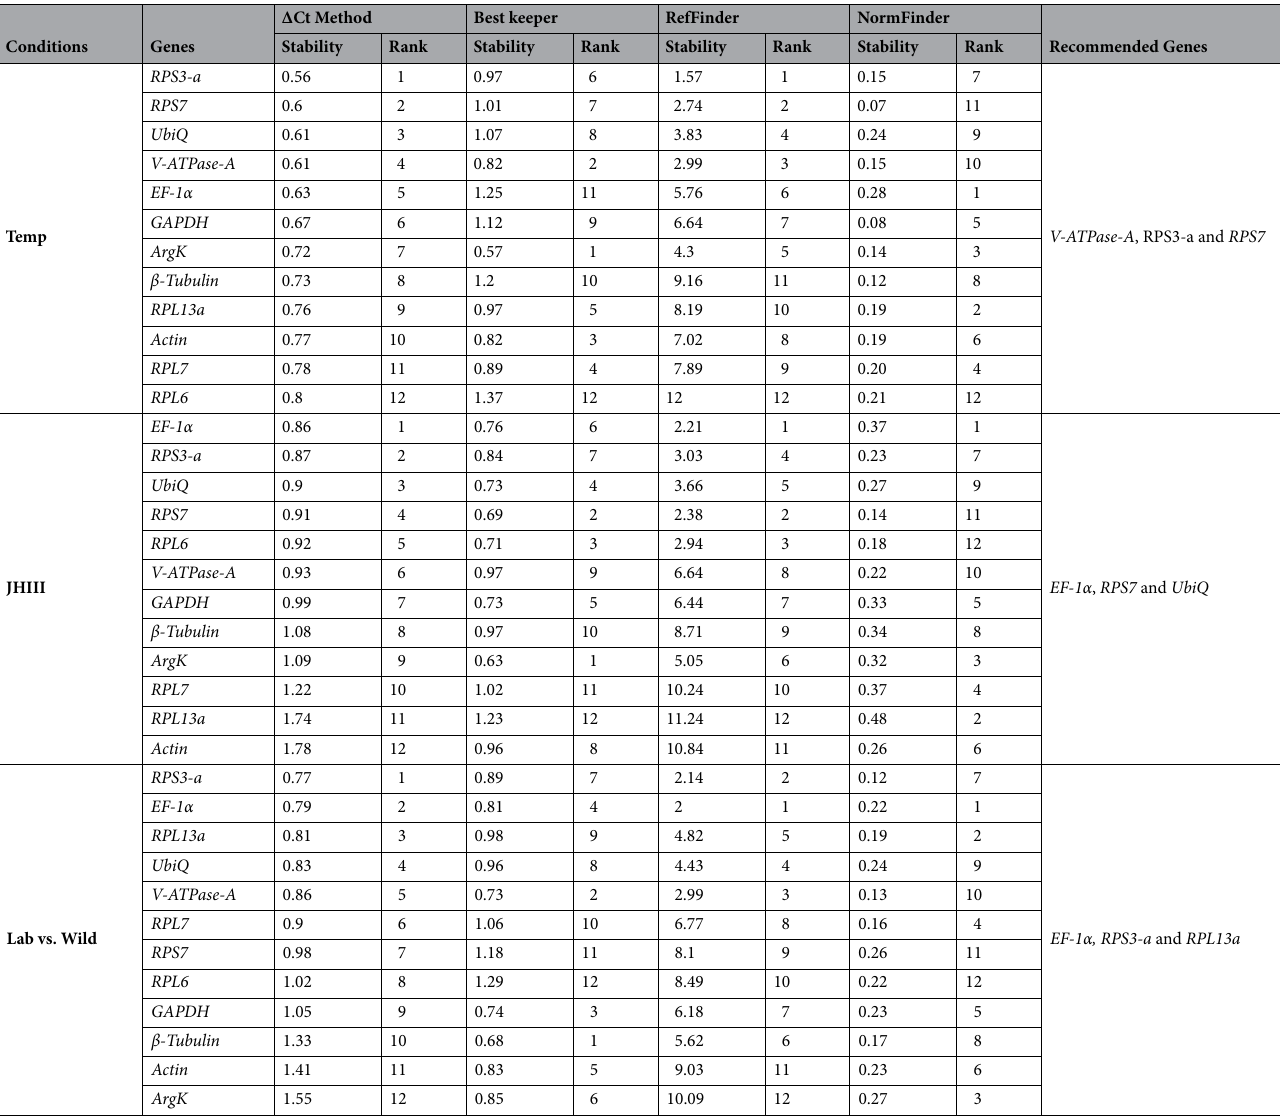
Table 5. Under the influence of abiotic factors, the candidate reference genes were ranked based on stability values performed by Delta Ct, BestKeeper, RefFinder, and NormFinder. The abiotic factors were temperature (temp), JHIII treatment, lab-reared vs wild-collected